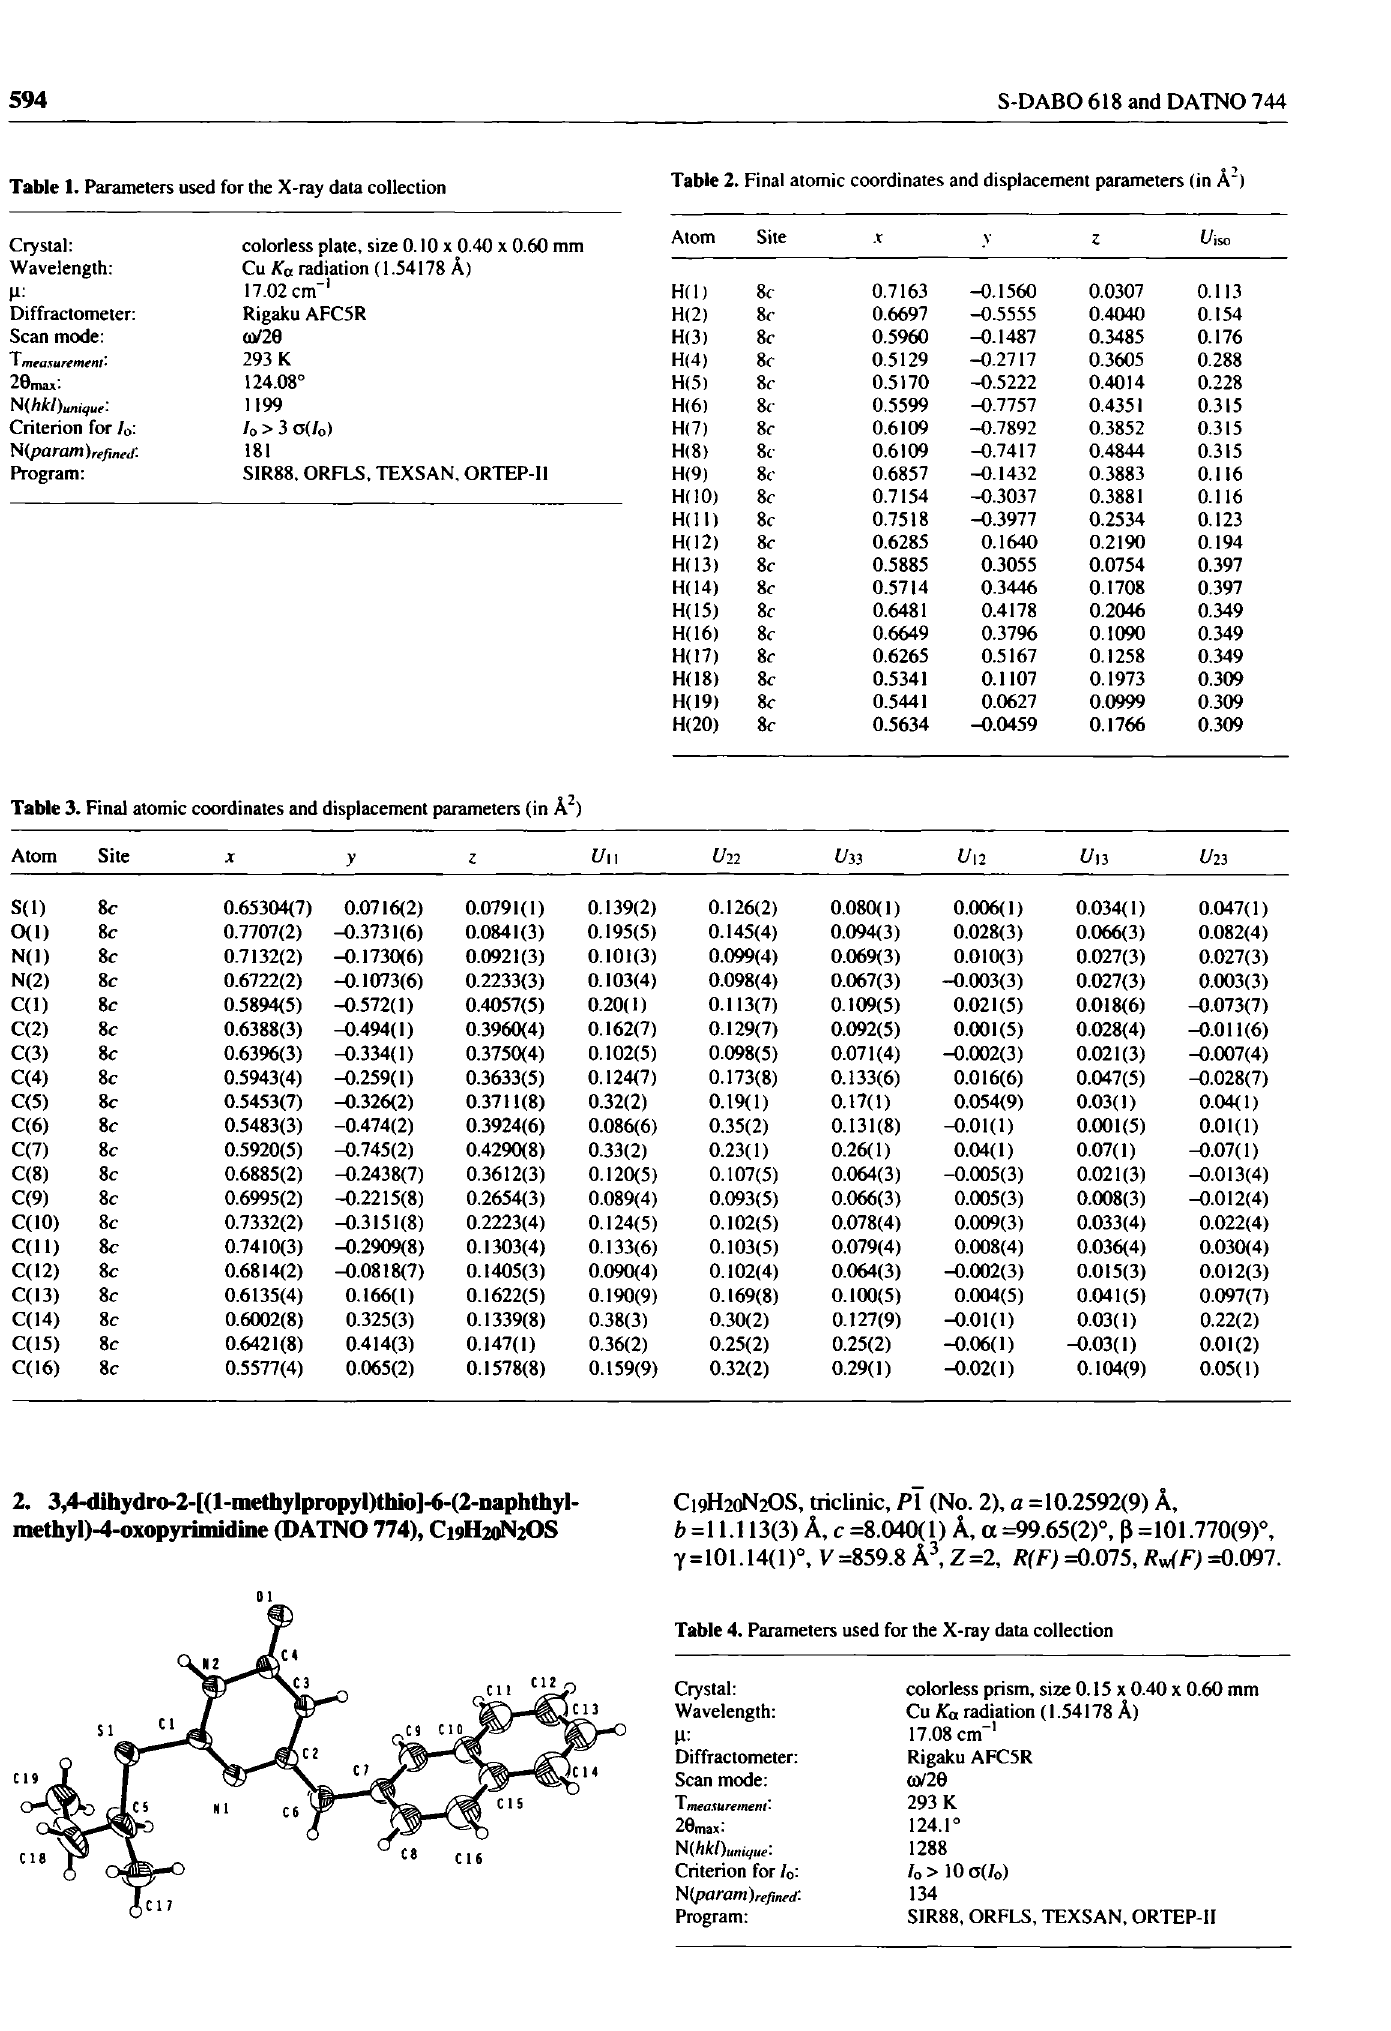
Table 1. Parameters used for the X-ray data collection Table 2. Final atomic coordinates and displacement parameters (in Â")